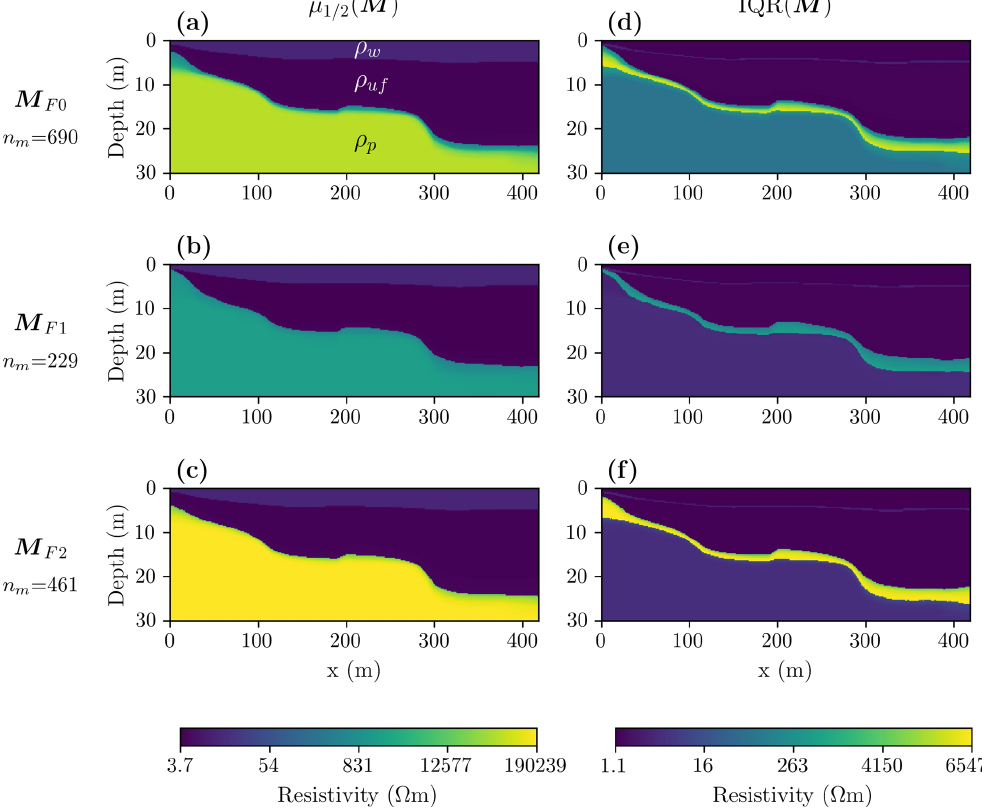
Figure 2. Inversion results for the Bykovsky data set illustrated as summary statistics for all obtained models M F0 and for two model families M F1 and M F2 as found by cluster analysis. (a–c) Median and (d–f) interquartile range models. For each M Fi , n m represents the number of models in the corresponding